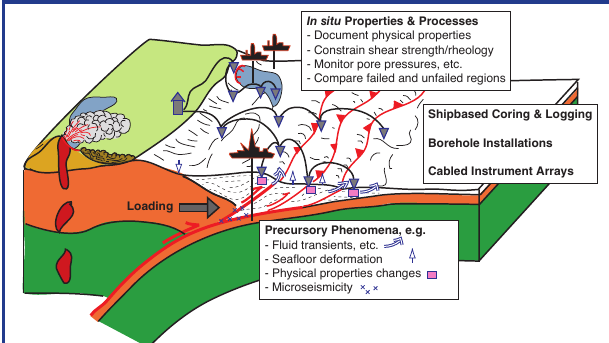
Figure 13. [A] Graphic representation of thickness and frequency of emplacement of organic turbidites in ODP drill sites 950, 951, and 952 (Northwest African Continental Margin). Each turbidite is represented by a vertical bar, and the thickness of the turbidite is shown on the vertical axis. Ages in Ma are given along the horizontal axis, and the separation between ticks on this axis reflects the number of turbidites deposited in that interval. [B] Summary of frequency-magnitude data through time for the data set shown in A. [C] Location map for study (modified from Weaver,